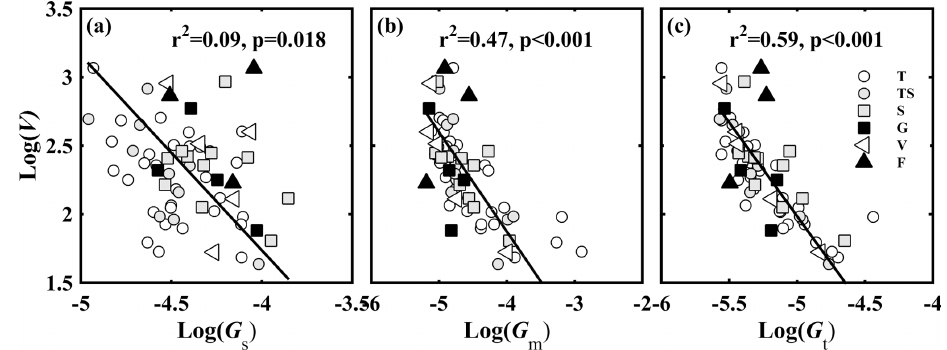
Figure 2. Relationships between (a) V and G s ; (b) V and G m ; and (c) V and G t . V is the ratio of photosynthetic capacity ( V cmax ) to light- saturated net photosynthesis ( A , µmolCO 2 m − 2 s − 1 ) ; G s is the ratio of stomatal conductance to CO 2 ( g s , molCO 2 m − 2 s − 1 ) to A ; G m is the ratio of mesophyll conductance to CO 2 ( g m , molCO 2 m − 2 s − 1 ) to A ; and G t is the ratio of total conductance to CO 2 ( g t , molCO 2 m − 2 s − 1 ) to A . Lines refer to regression line for 63 species. T, TS, S, G, V, and F represent tree, tree/shrub, shrub, grass, vine, and fern,